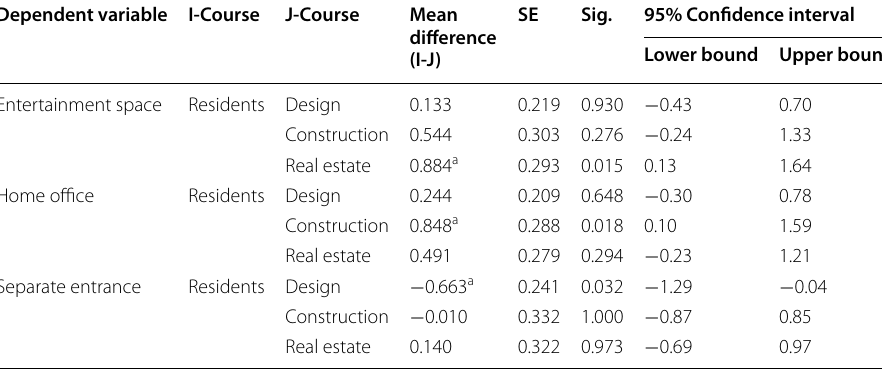
Table 7 Post hoc Tukey’s HSD